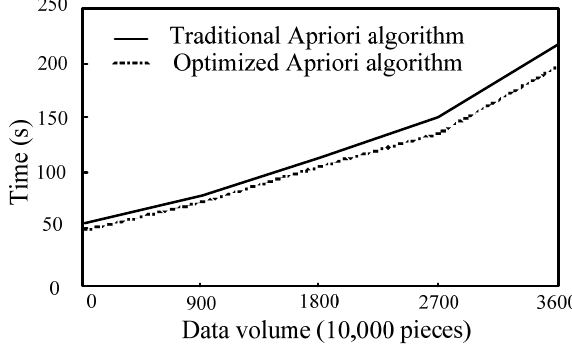
Figure 5. Running time of association rule algorithm.